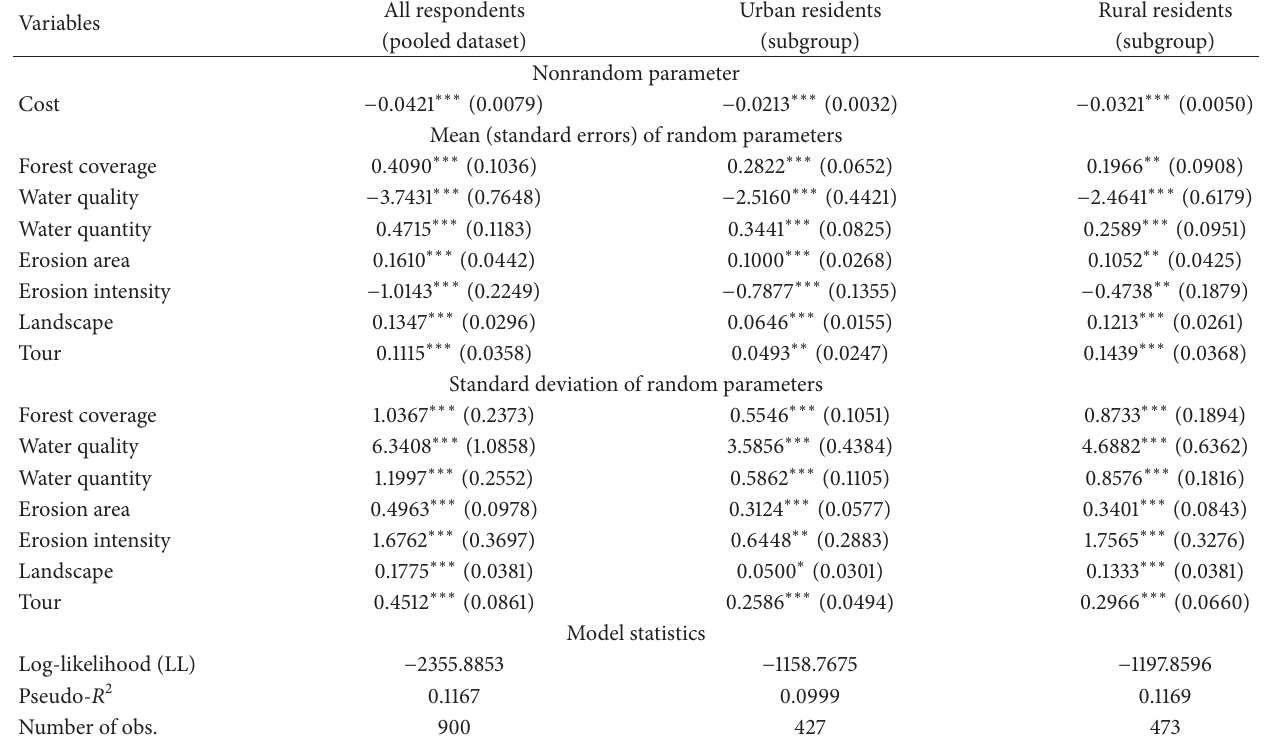
Table 6: Mixed logit model